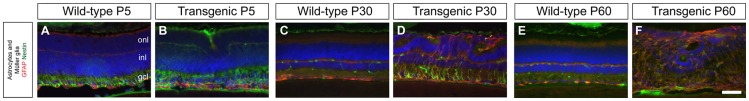
Analysis of makers for glial cells.Wild-type (A, C, E) and transgenic (B, D, F) retinas were cross-sectioned and stained with GFAP (red) and Nestin (green) at ages P5, P30 and P60. Scale bar A–L 50 µm. Outer nuclear layer (onl), inner nuclear layer (inl), ganglion cell layer (gcl).